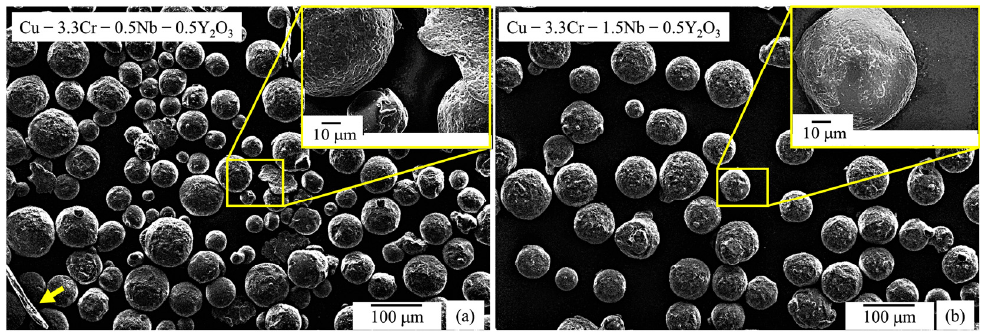
Figure 3. SEM images (SE mode) of mechanically alloyed powder particles with superimposed SEM image with higher magnification: ( a ) Cu-3.3Cr-0.5Nb alloy. ( b ) Cu-3.3Cr-1.5Nb alloy. Table 3. Chemical composition (in wt.%) of the surface of the mechanically alloyed powder depicted in Figure 2a,b. Averaged values from single-point measurements on 15 randomly selected powder particles. GA: gas-atomized, MA: mechanically